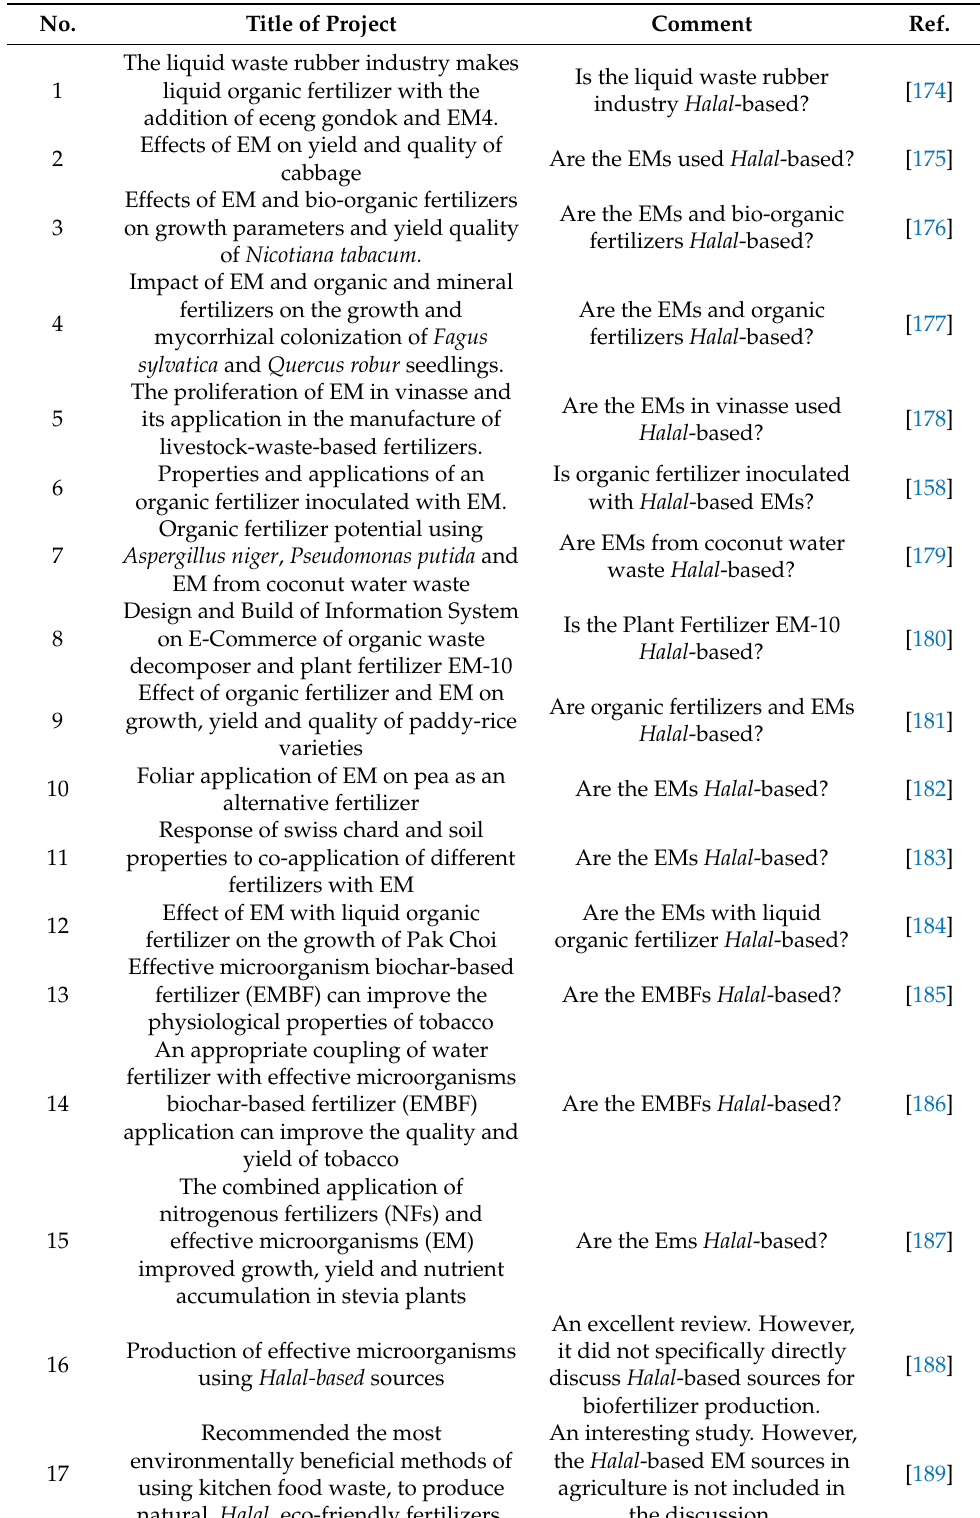
Table 1. Title of publications including the keywords ‘Effective Microorganism’ (EM) and ‘fertilizer’ obtained from the Scopus database searched on 29 January